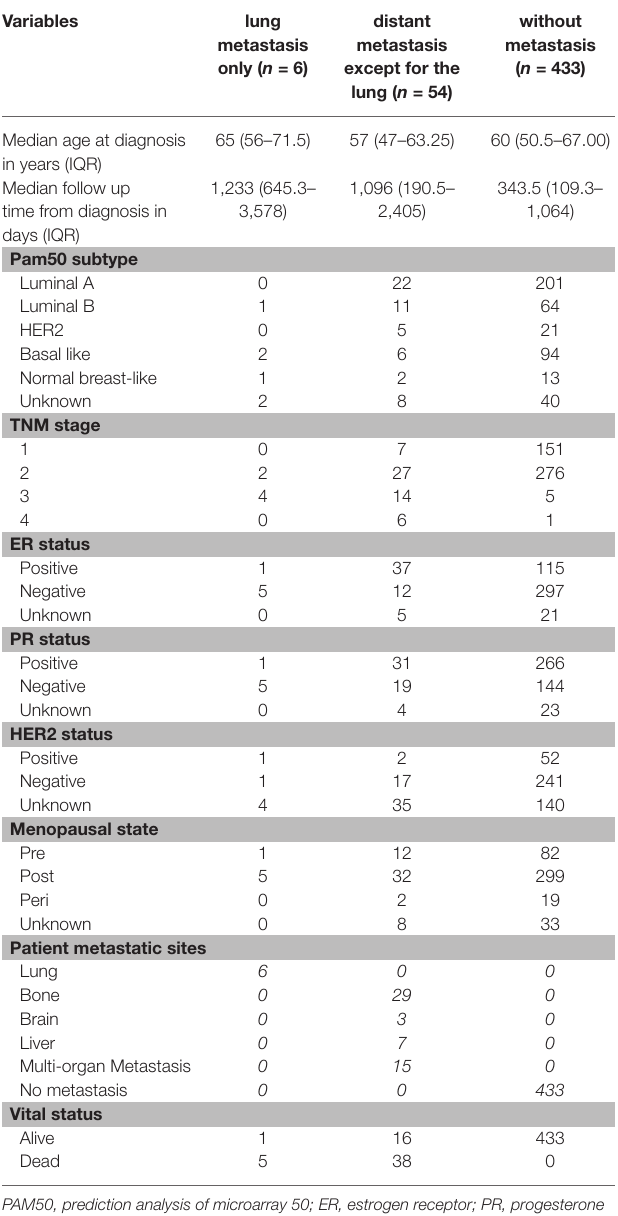
TABLE 6 | Demographics of the samples recruited in subgroup